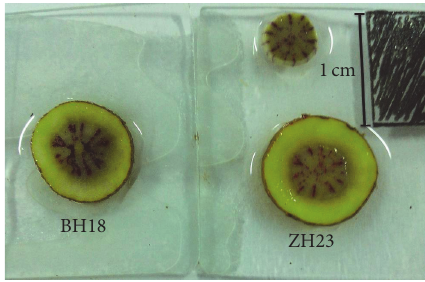
Figure 7: Lignin staining of BH18 and